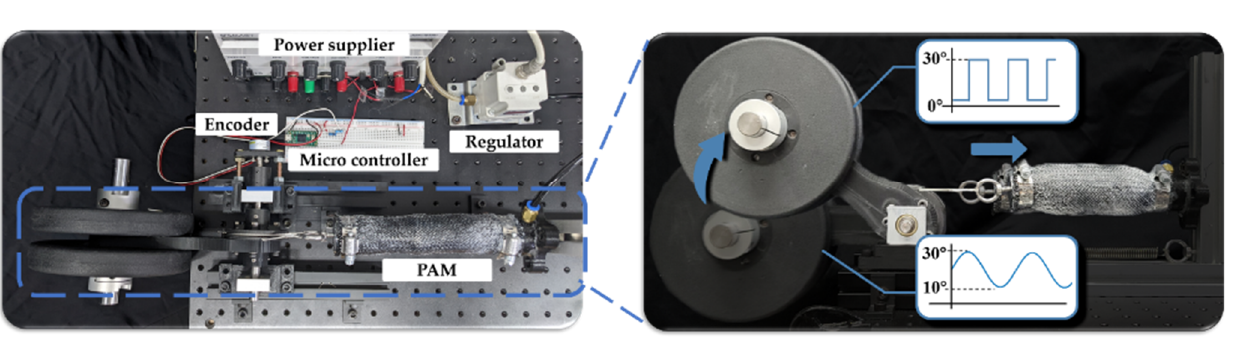
Figure 6. One degree of freedom testbed setup for the dynamic condition experiment.